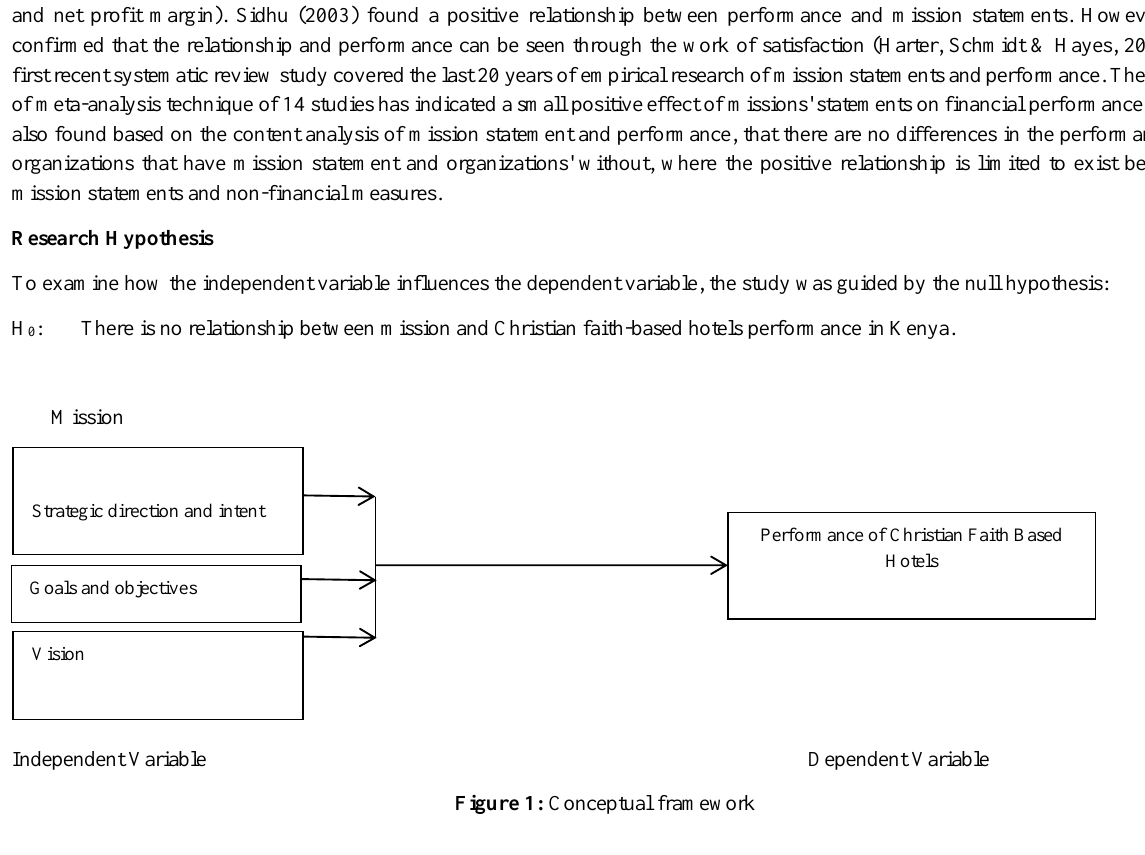
Figure 1: Conceptual framework